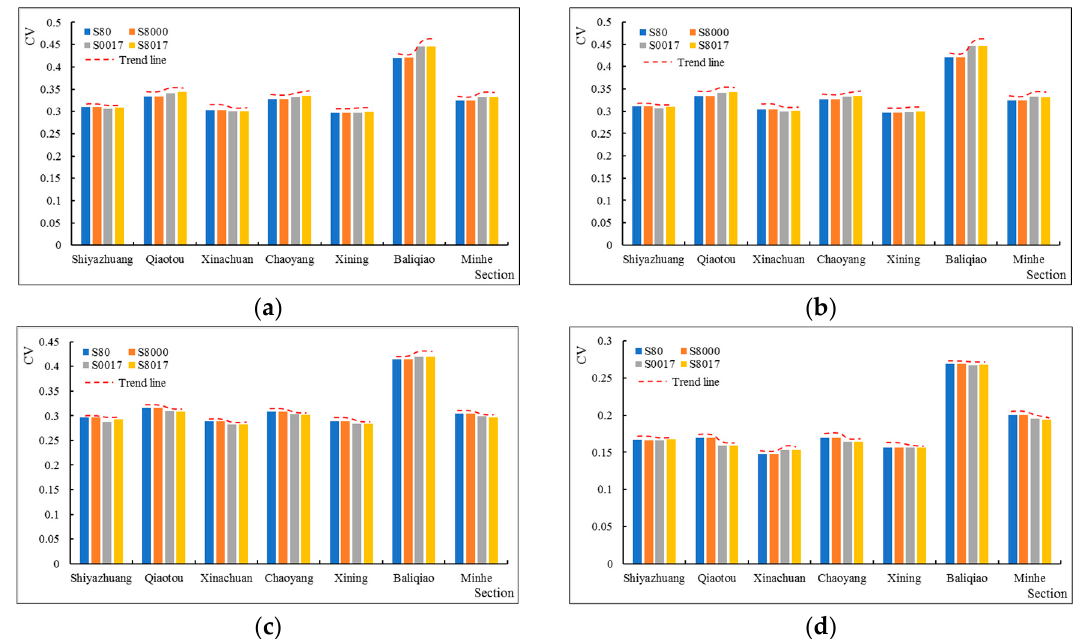
Figure 12. ( a ) Comparison of the annual CV for seven sections under different slope ecological restoration scenarios; ( b ) Comparison of wet season CV for seven sections under different slope ecological restoration scenarios; ( c ) Comparison of temperate season CV for seven sections under different slope ecological restoration scenarios; ( d ) Comparison of dry season CV for seven sections under different slope ecological restoration scenarios.